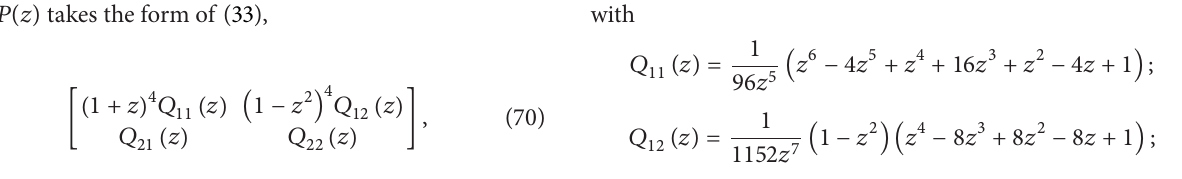
then 𝑃(𝑧) takes the form of